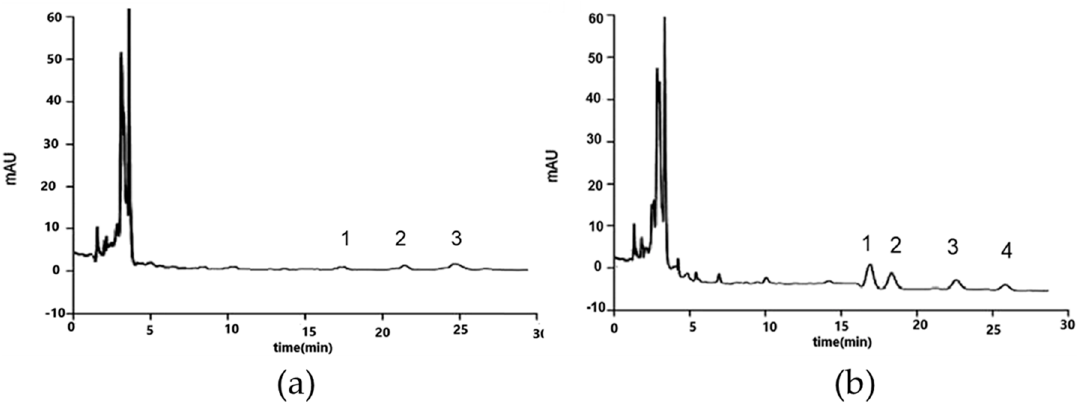
Figure 5. Chromatogram obtained by MAE-DLLME-HPLC-UV (microwave-assisted extraction-dispersive liquid-liquid micro extraction-high performance liquid chromatography-ultraviolet detection) for toasted bread. ( a ) Non-spiked sample (b) Sample spiked with 20 ng/g of PAH4, (1) benzo (a) anthracene; (2), chrysene; (3) benzo ( b ) fl uoranthene; (4) benzo (a) pyrene. Reprinted from Reference [51] with permission from Royal Society of Chemistry.